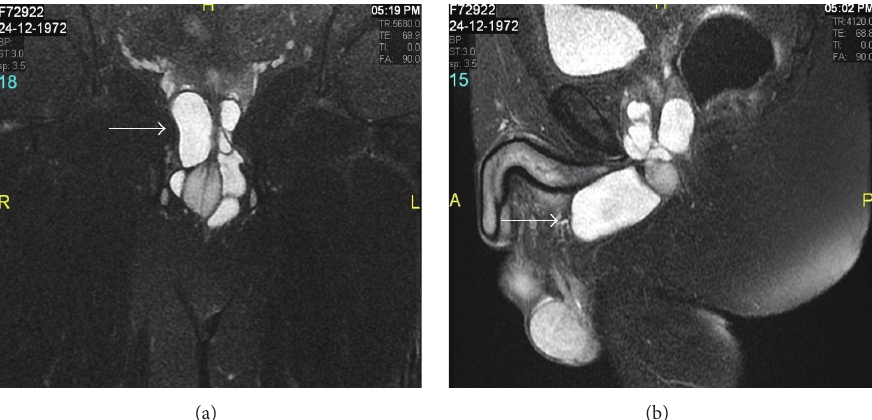
Figure 2: Coronal (a) and sagittal (b) T2-Fatsat images reveal hyperintense, multiloculated, tortuous, tubular, septated cystic structures encircling the compressed proximal bulbar urethra-giant sized Cowper’s gland syringocele.